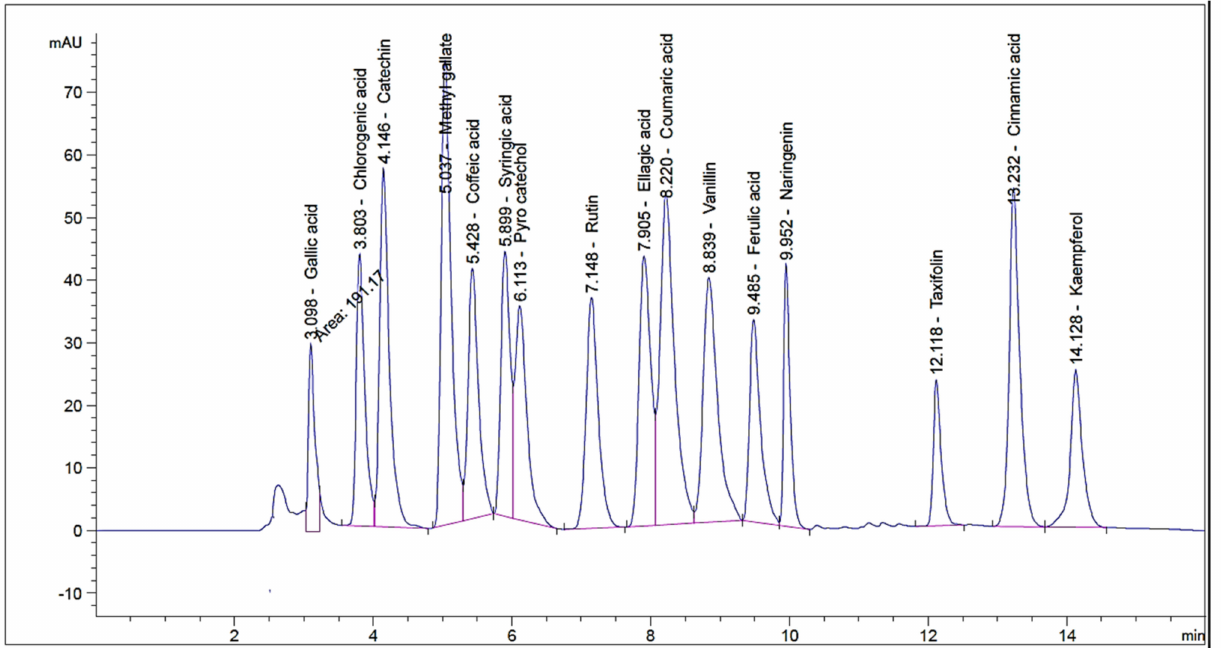
Figure 1. HPLC chromatogram of phenolic compounds (standard